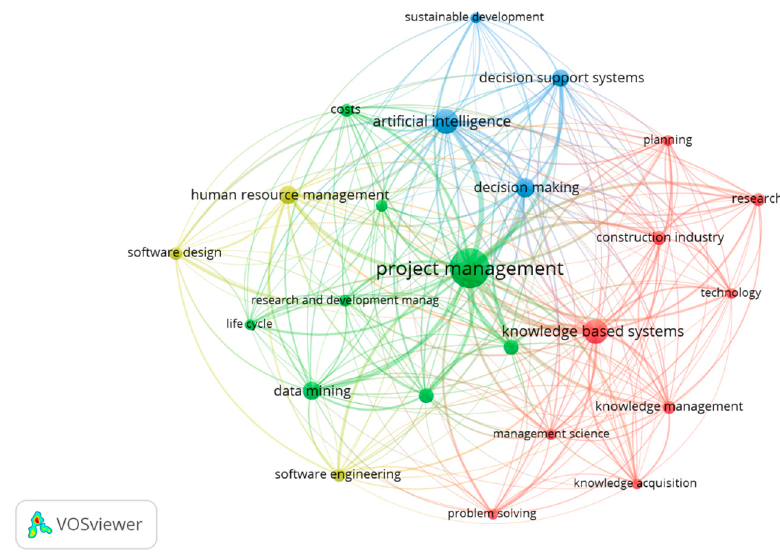
Figure 8. Clusters identified in the Work domain.